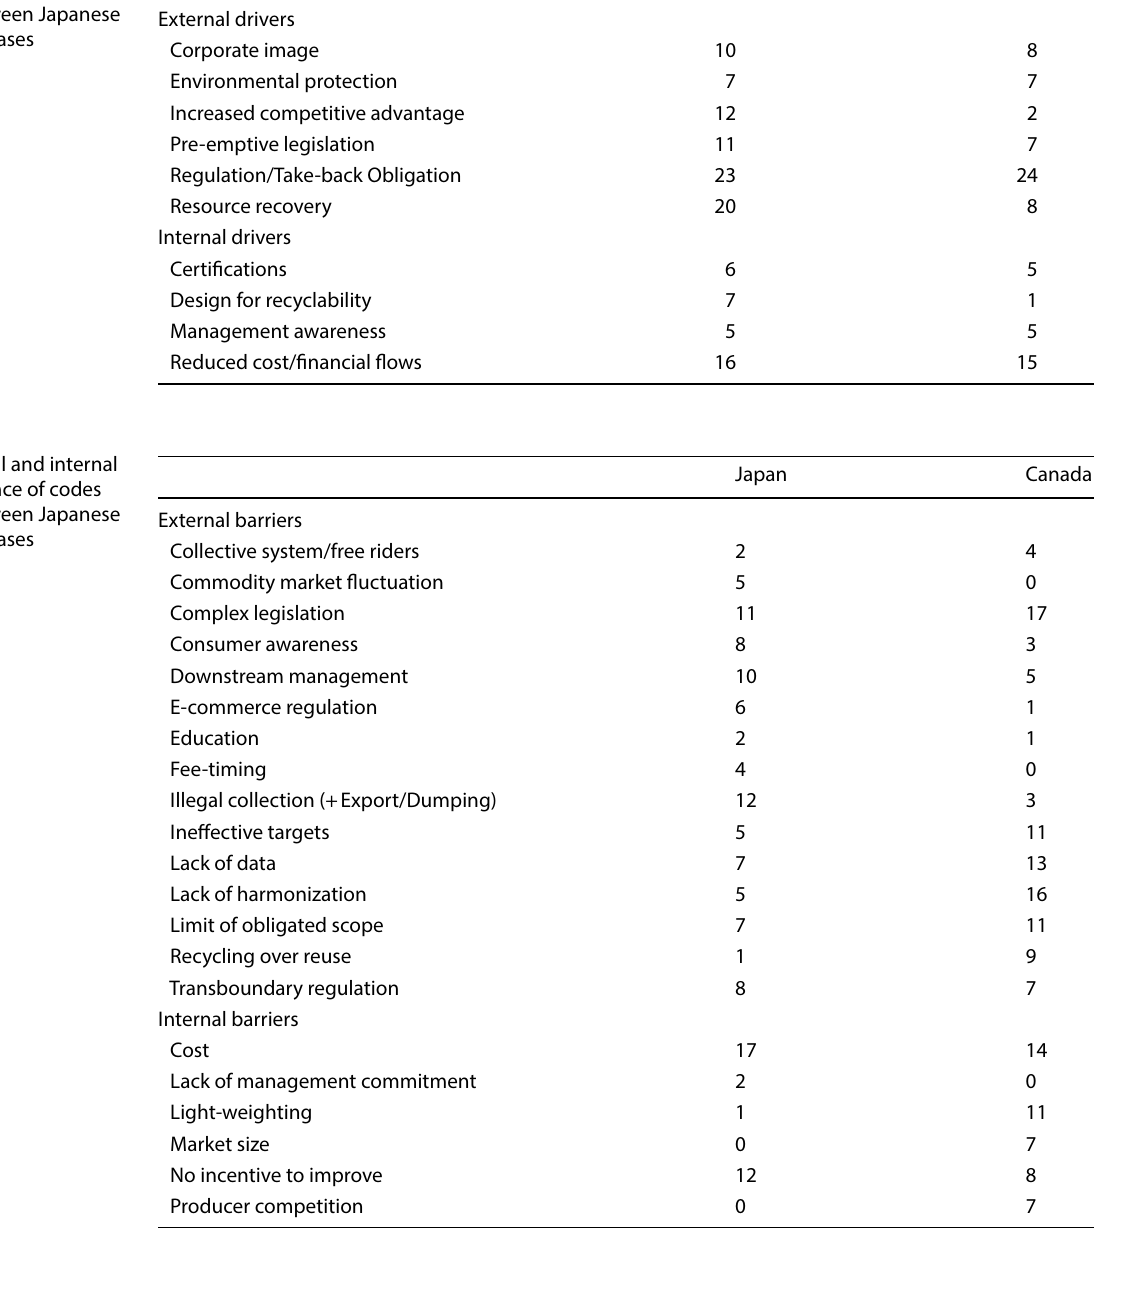
Table 5 External and internal drivers: incidence of codes compared between Japanese and Canadian cases